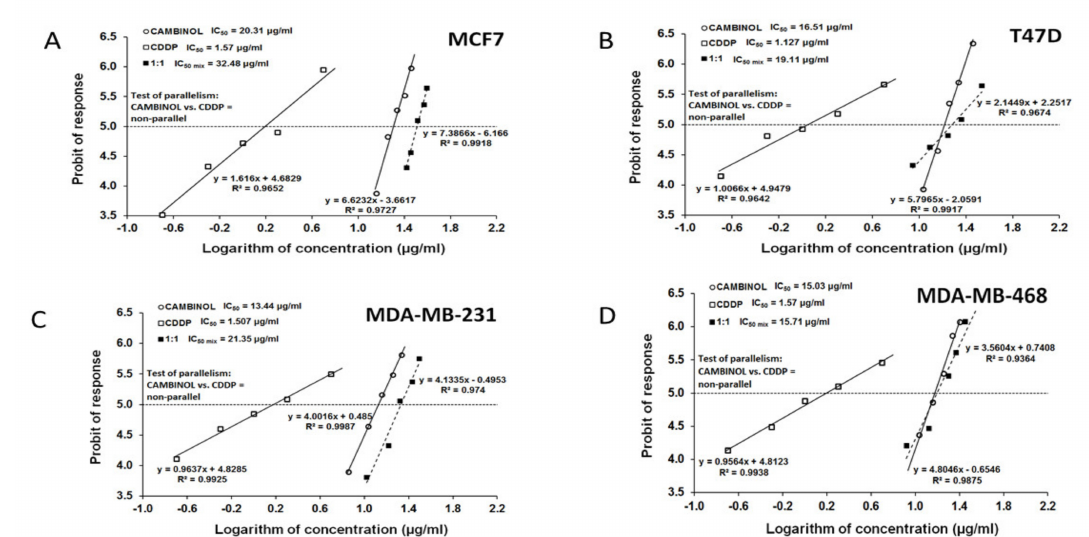
Figure 3. The log-probit dose–response relationship lines for CAM and CDDP in MCF7, T47D, MDA-MB-231, and MDA-MB- 468 cell lines. ( A ) Log-probit dose–response relationship lines for CAM and CDDP administered alone and in combination at the fixed-ratio of 1:1, with respect to their anti-proliferative effects on the MCF7 cell lines. ( B ) Log-probit dose–response relationship lines for CAM and CDDP administered alone and in combination at the fixed-ratio of 1:1, with respect to their anti-proliferative effects on the T47D cell lines. ( C ) Log-probit dose–response relationship lines for CAM and CDDP administered alone and in combination at the fixed-ratio of 1:1, with respect to their anti-proliferative effects on the MDA-MB-231 cell lines. ( D ) Log-probit dose–response relationship lines for CAM and CDDP administered alone and in combination at the fixed-ratio of 1:1, with respect to their anti-proliferative effects on the MDA-MB-468 cell lines.